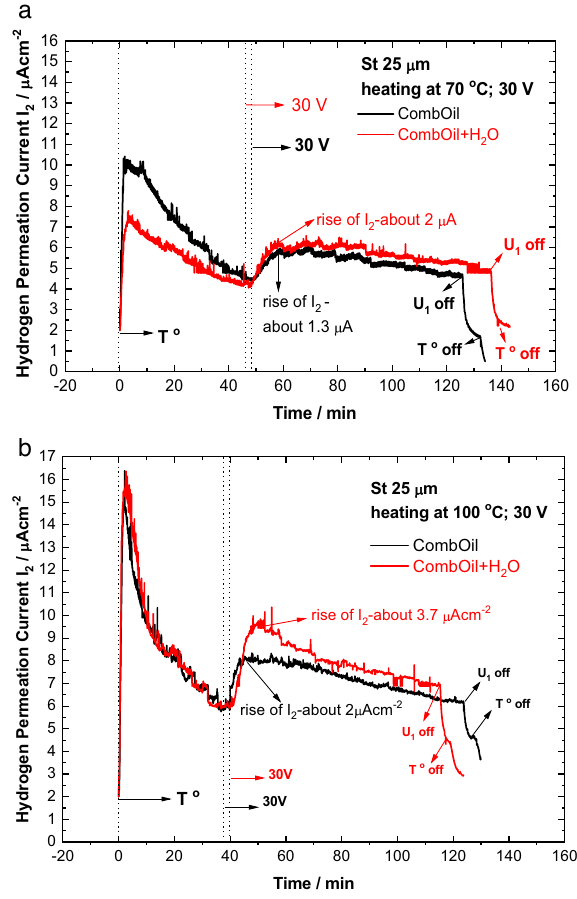
Figure 6. Hydrogen permeation transients recorded with CombOil and CombOil + H 2 O under voltage of 30 V and upon heating at 70 °C ( a ) or 100 °C ( b